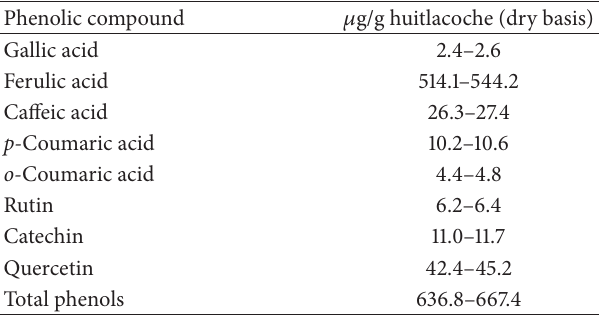
Table 5: Phenolic compounds of huitlacoche from creole Mexican